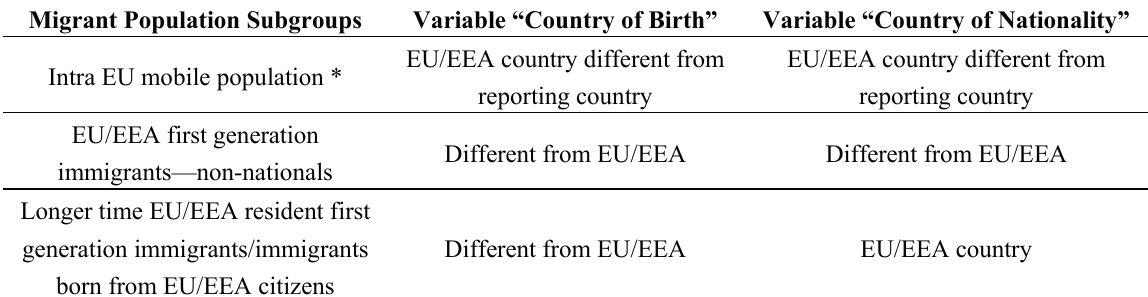
Table 4. Migrant population subgroups diversified on the basis of existing